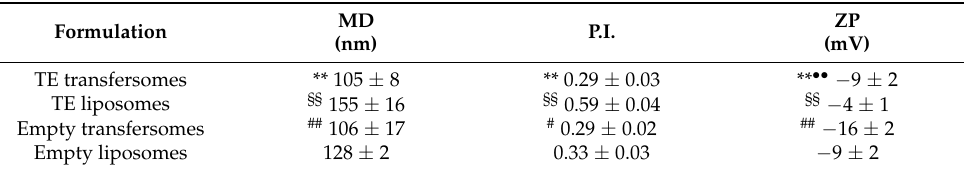
Table 3. Characteristics of TE transfersomes in comparison with TE liposomes, empty liposomes, and empty transfersomes: mean diameter, polydispersity index (P.I.), and zeta potential (ZP). The values are the means ± the SDs ( n > 6). ** TE transfersomes vs. TE liposomes: ** p < 0.01; •• TE transfersomes vs. empty transfersomes: •• p < 0.01; §§ TE liposomes vs. empty liposomes: §§ p < 0.01; # empty transfersomes vs. empty liposomes: # p < 0.05, ## p < 0.01.